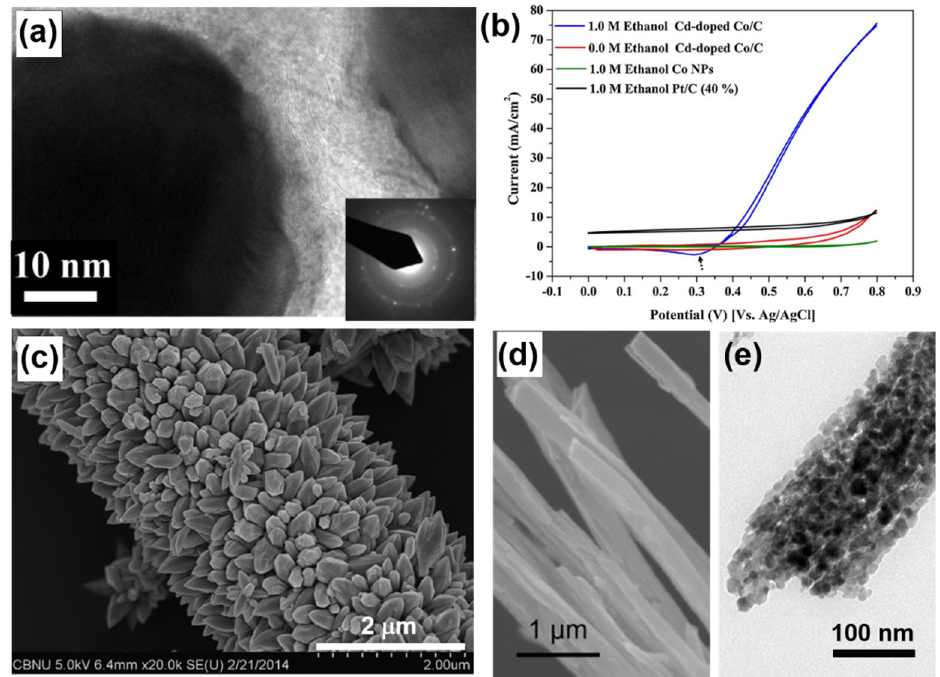
Figure 10. ( a ) TEM image of CoCd/C nanostructures. The inset is the selected-area electron diffraction pattern of the nanoparticle; ( b ) cyclic voltammograms for Cd-doped Co/C catalysts, Pt/C (40%) and pristine cobalt nanoparticles in 1 M KOH solution with 1.0 M ethanol. Reproduced with permission